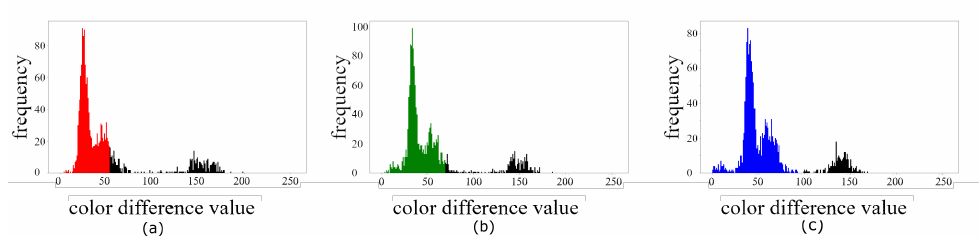
Figure 4. Partitioning each distribution of the absolute stitching c-color, c ∈ {R, G, B}, difference values in Figure 2 into two classes. ( a ) For R-color. ( b ) For G-color. ( c ) For B-color.